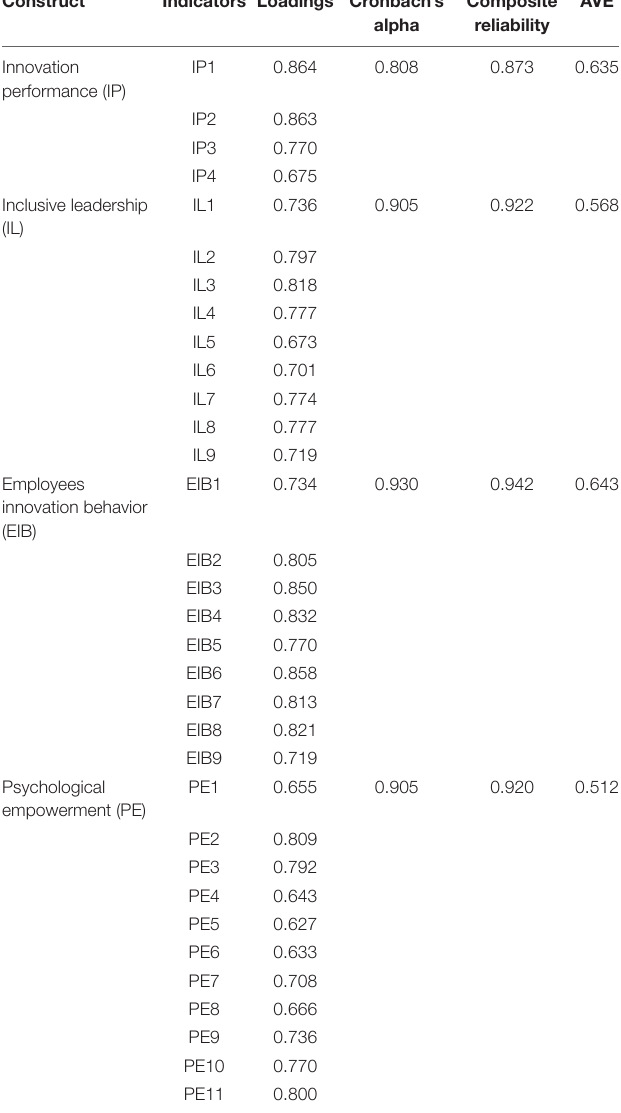
TABLE 2 | Internal consistency, convergent validity, composite reliability, and AVE.